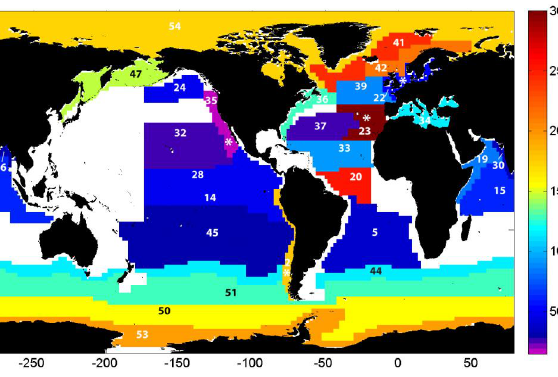
Figure 7. Global distribution of POC export fluxes derived from Fig. 7: Global distribution of POC export fluxes derived from the 234 Th technique (in mg m -2 273 the 234 Th technique (in mgm − 2 d − 1 d -1 ). 274